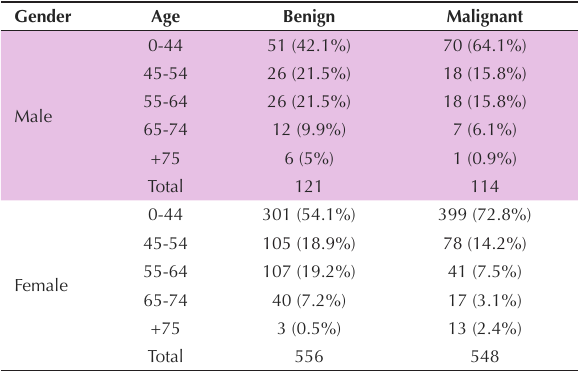
Table 1. Trends in the occurrence of thyroid cancer according to age and gender Gender Age Benign